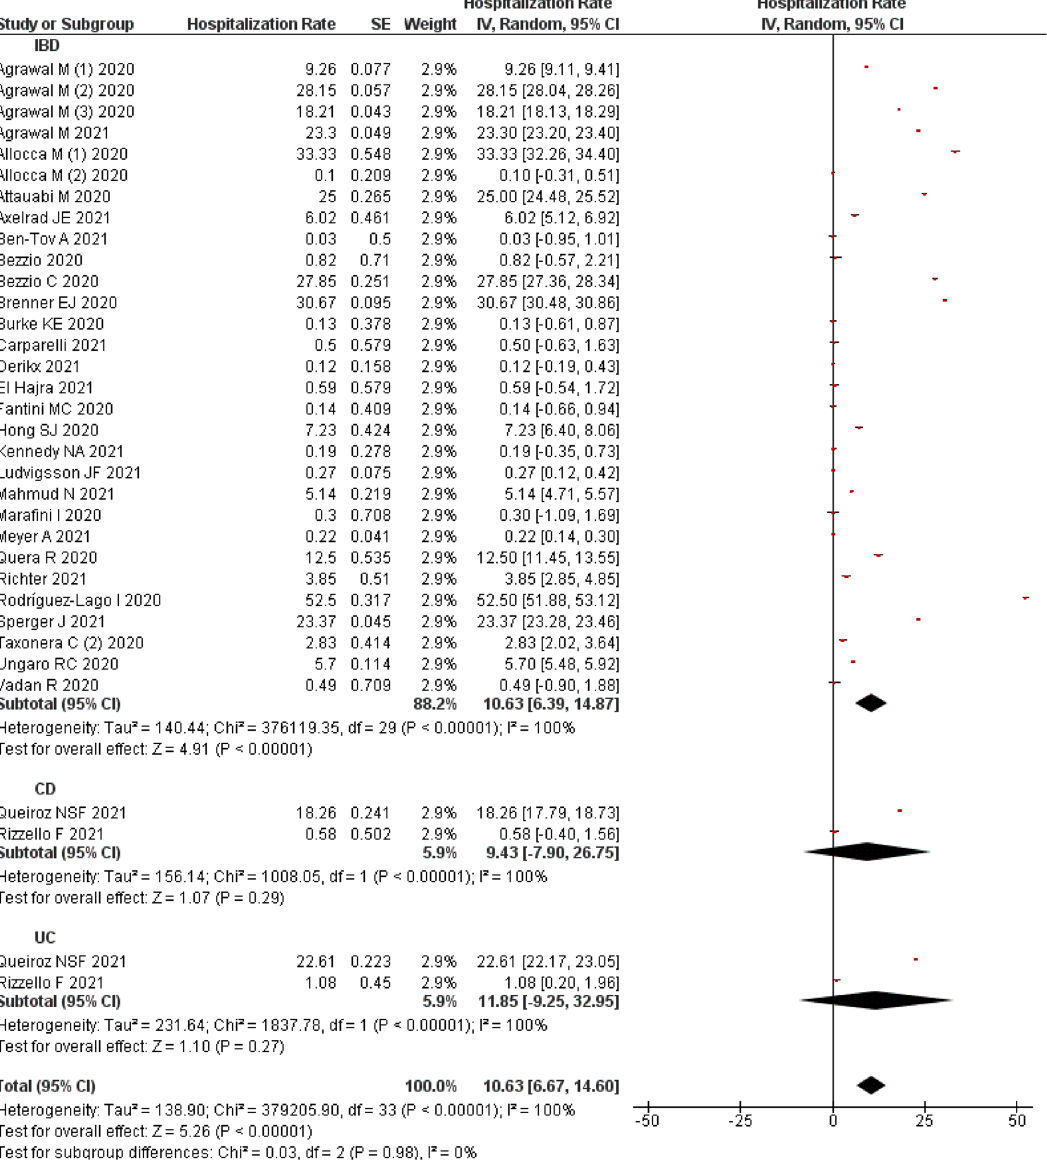
Figure 4. COVID-19 hospitalization among the patients with